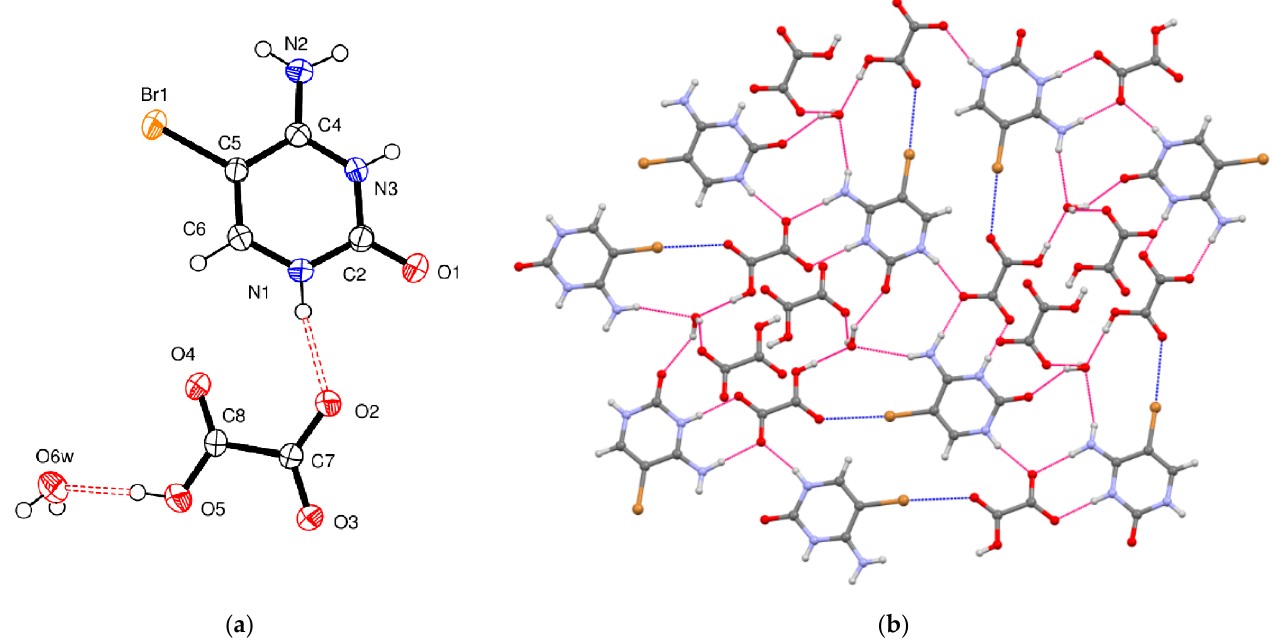
Figure 6. ( a ) The asymmetric unit of compound ( VI ), showing the adopted atom-numbering scheme. Displacement ellipsoids are at the 50% probability level. H atoms are shown as small spheres of arbitrary radii. Hydrogen bonding is shown as red dashed lines. ( b ) Part of the crystal structure of ( VI ). All atoms are shown as small spheres of arbitrary radii. Hydrogen bonding is shown as red dashed lines. Halogen bonding is shown as blue dashed lines.